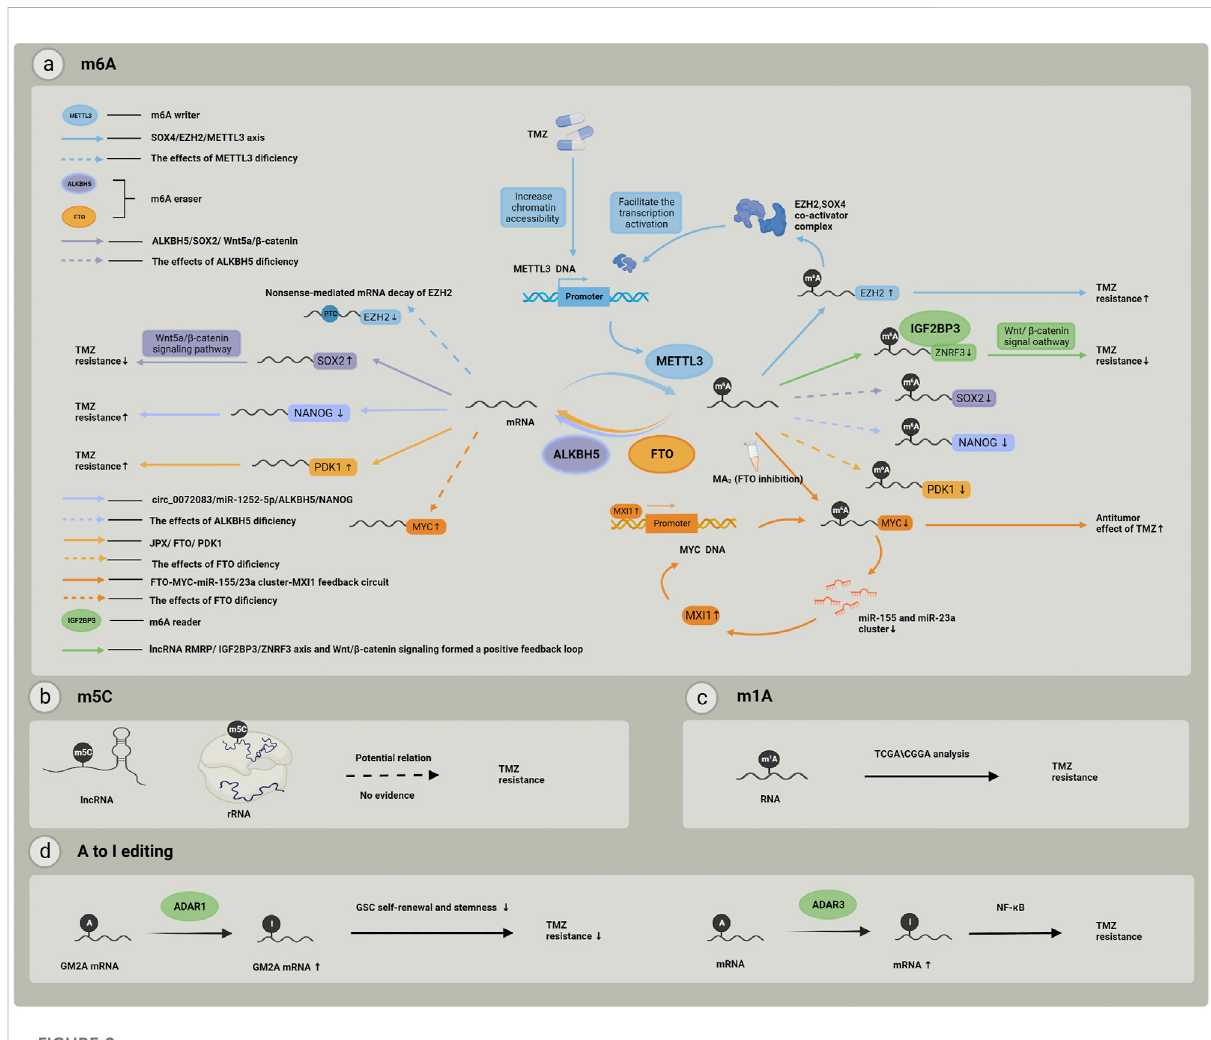
FIGURE 2 RNA modi fi cation and related regulators involved in TMZ resistance. (A) RNA m6A modi fi cation and its “ writers ” , “ erasers ” and “ readers ” , each color represents one individual pathway related to m6A modi fi cation regulators, and these pathways may fi nally cause different effect to